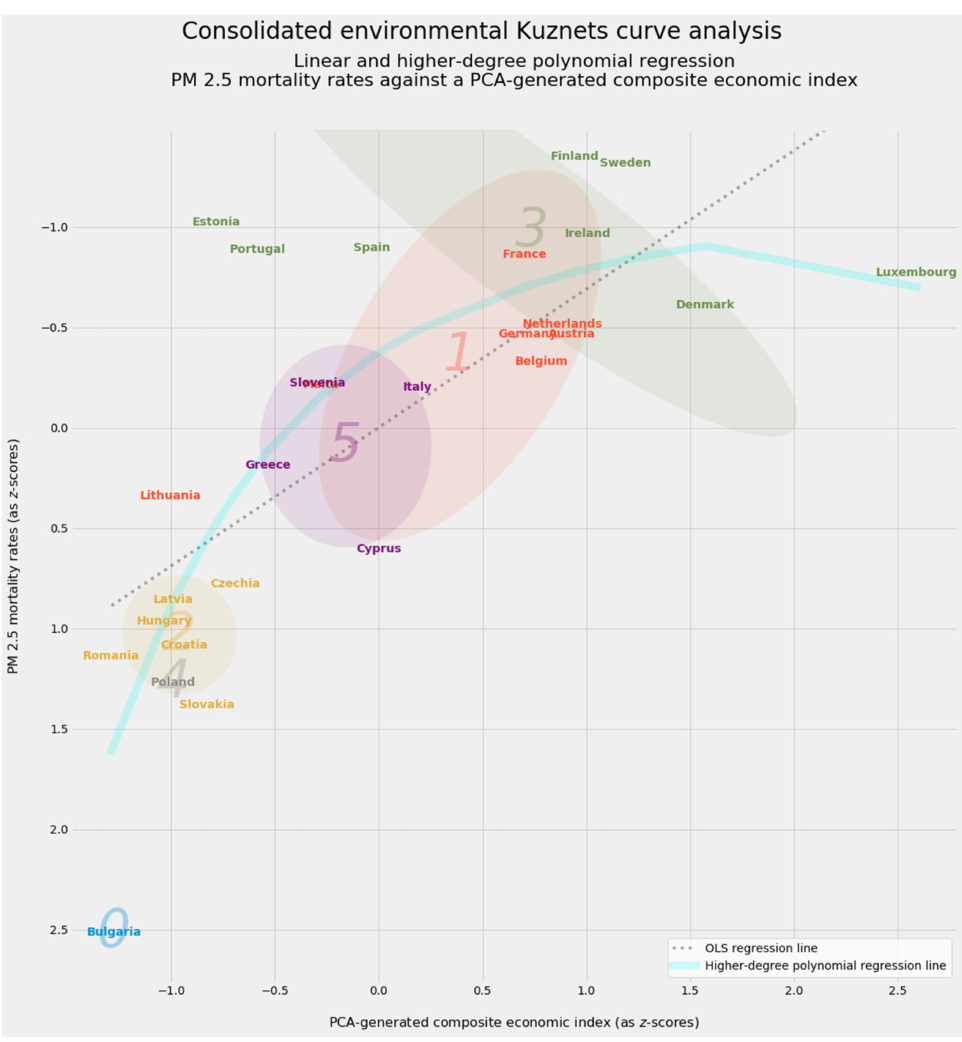
Figure 16. The environmental Kuznets curve for the PCA-generated composite economic